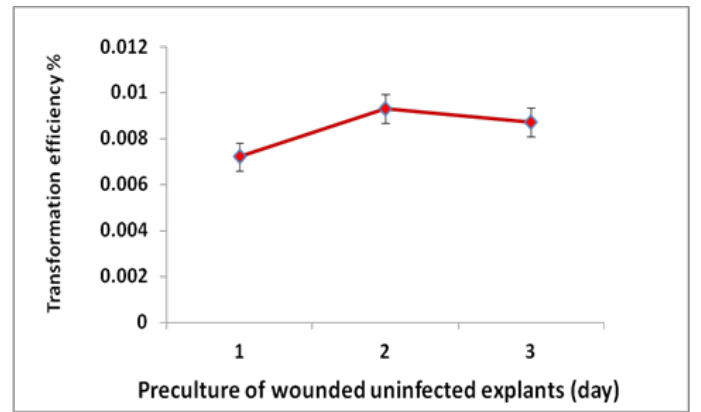
Figure 3. Precultured, wounded poplar explants before induction by Agrobacterium